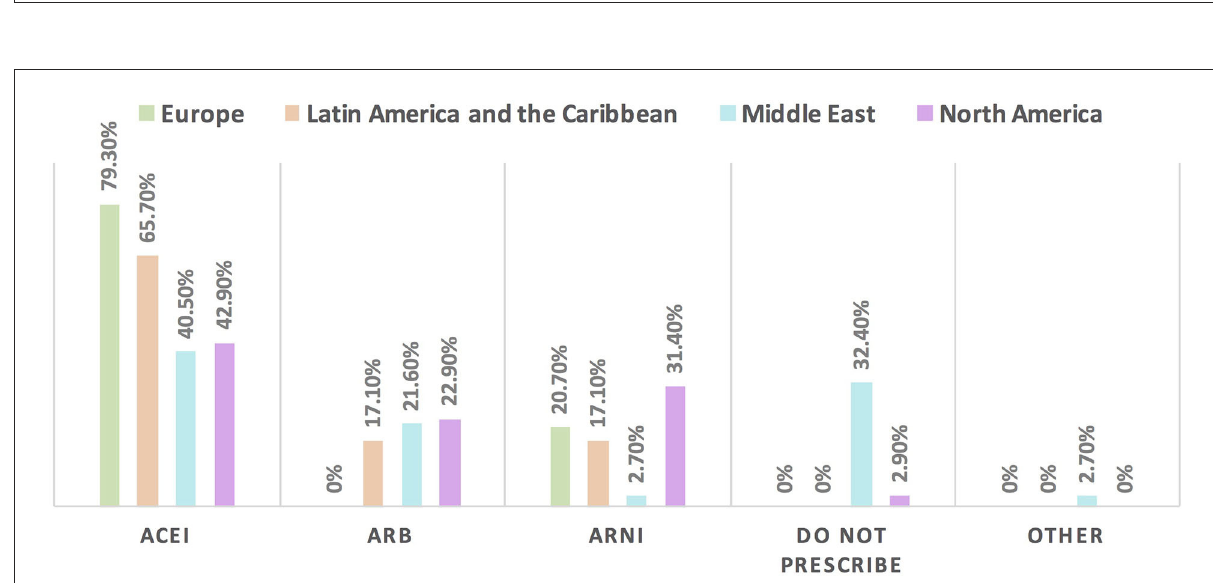
FIGURE7 The most commonly prescribed RAAS inhibitor for patients with cancer and HFrEF in different continents. For patients with cancer and HFrEF, the main RAAS inhibitor to be used is ACEI followed by ARNI except in the Middle East where ARB is the second choice. Of note, respondents in Europe did not choose ARB among the options. One-third of the respondents from the Middle East do not prescribe RAAS may be explained by the majority of respondents in this region being oncologists. ACEI, angiotensin-converting enzyme inhibitor; ARB, angiotensin receptor blocker; ARNI, angiotensin receptor-neprilysin inhibitors; HFrEF, heart failure with reduced ejection fraction; RAAS, renin-angiotensin-aldosterone